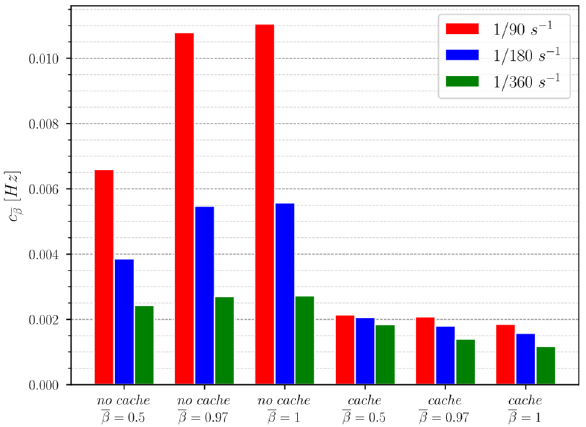
Figure 13. 𝑐 (cid:3081)(cid:3365) for 𝛼 = 0.9 , 𝐴𝑜𝐼 (cid:3080) = 420 s , 𝜆 = 1 (cid:3403) 360 s (cid:2879)(cid:2869) , 𝜆 = 1 (cid:3403) 180 s (cid:2879)(cid:2869) , and 𝜆 = 1 (cid:3403) 90 s (cid:2879)(cid:2869) . Figure 13. c for α = 0.9, AoI α = 420 s, λ = 1/360 s − 1 , λ = 1/180 s − 1 , and λ = 1/90 s − 1 . β